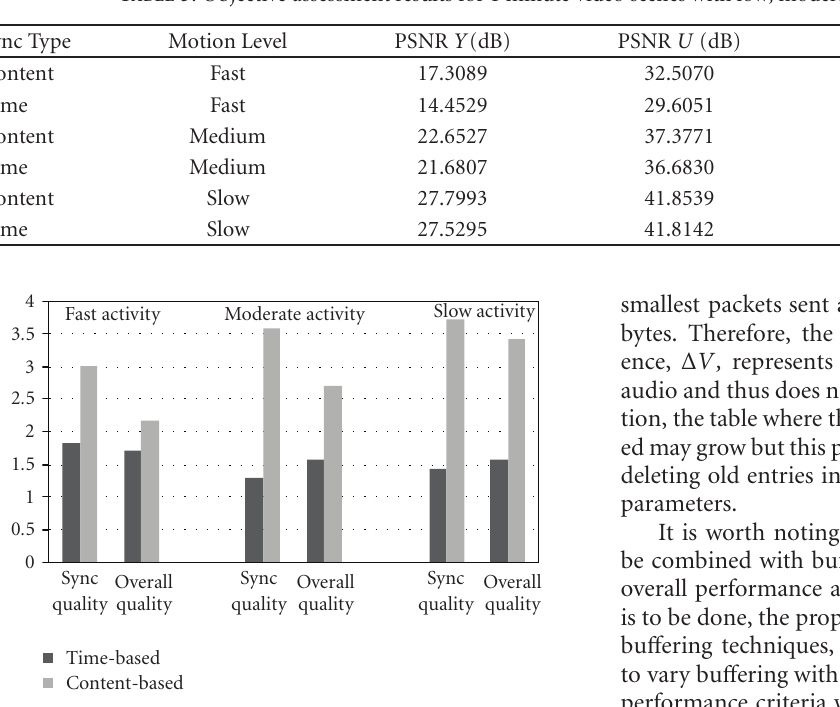
Table 5: Objective assessment results for 1 minute video scenes with low, moderate and high activity levels.